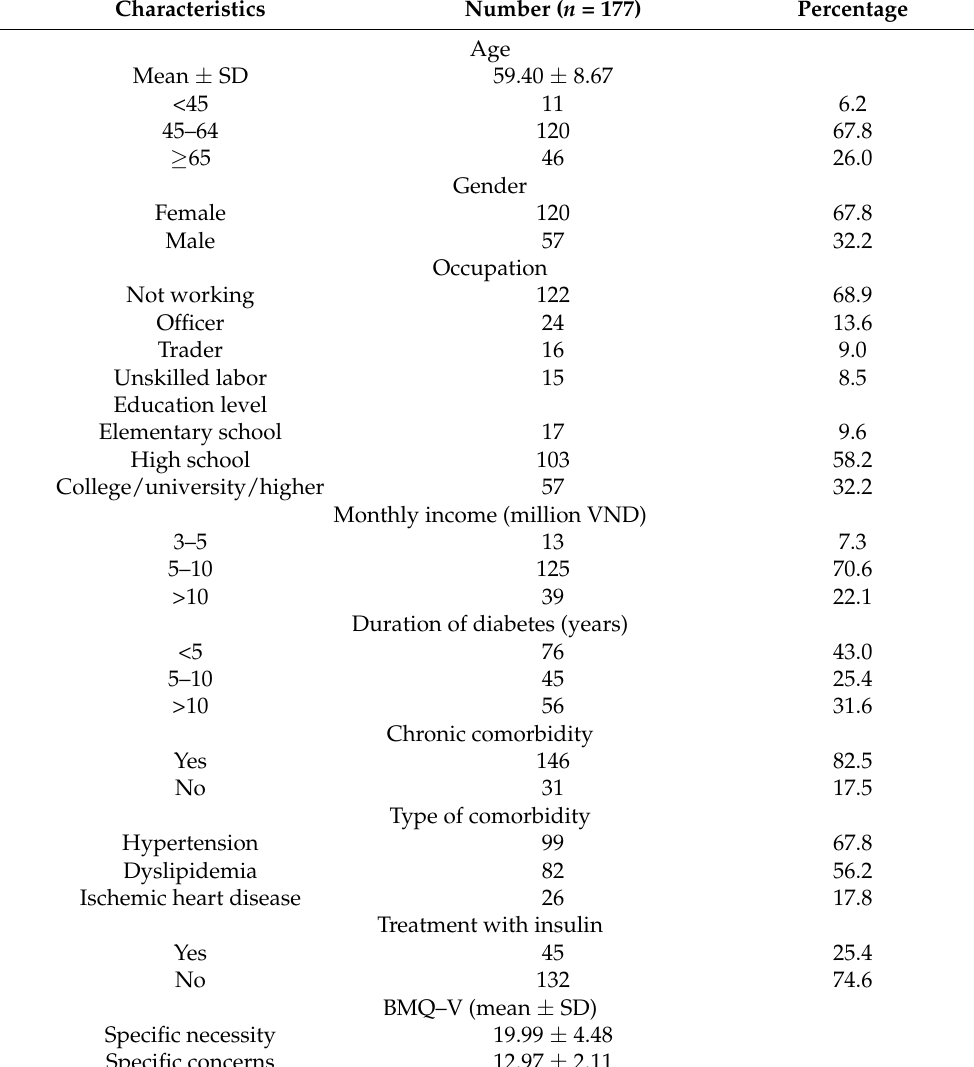
Table 1. Patients’ demographic characteristics.